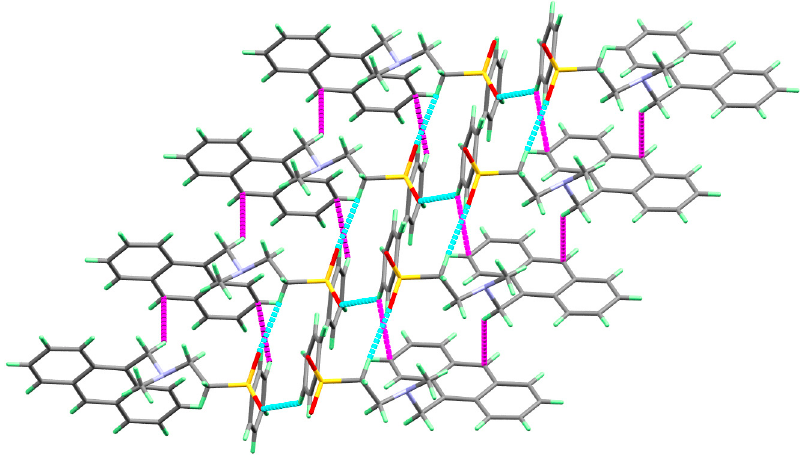
Figure 3. Molecular packing of molecule 3 via C-H... π (magenta) and O...H (red) interactions. Table 3. Intermolecular contacts (Å, °) observed in the crystal structure of molecule 3 .